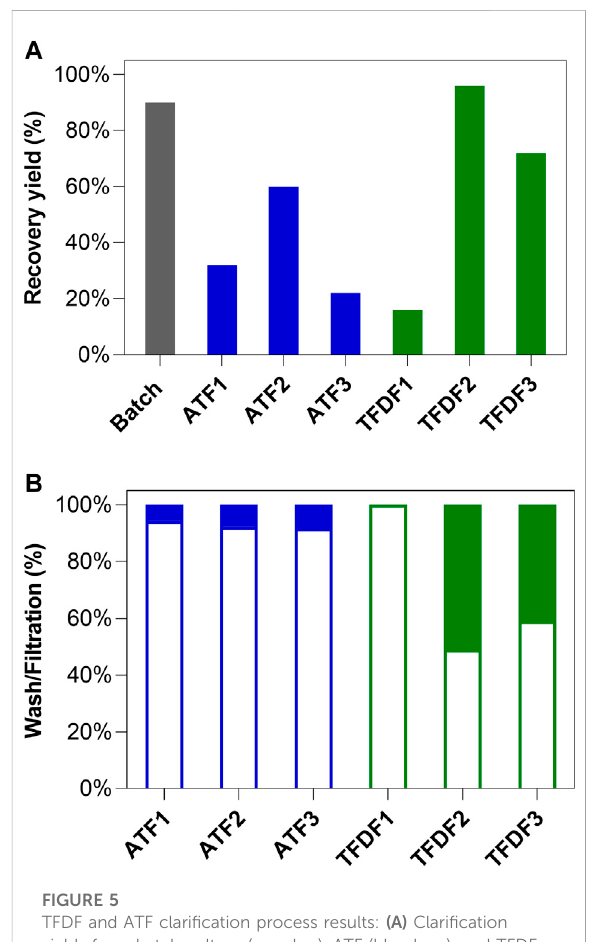
FIGURE 5 TFDF and ATF clari fi cation process results: (A) Clari fi cation yields from batch culture (grey bar), ATF (blue bars), and TFDF (green bars) runs; (B) Percentage of the recovered AAV during washing and fi ltration stages. The empty and full bars represent the recovery percentage of AAV in the wash and fi ltration stages